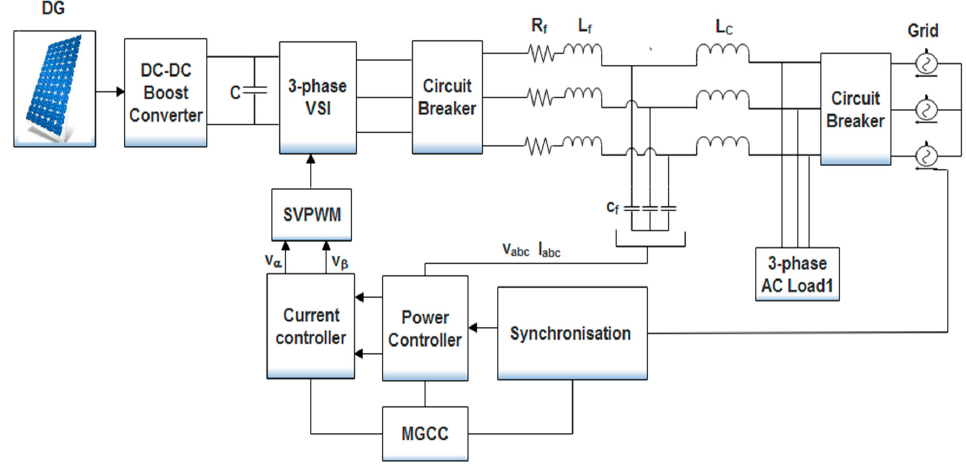
Figure 2. A generalized control structure for MGs.